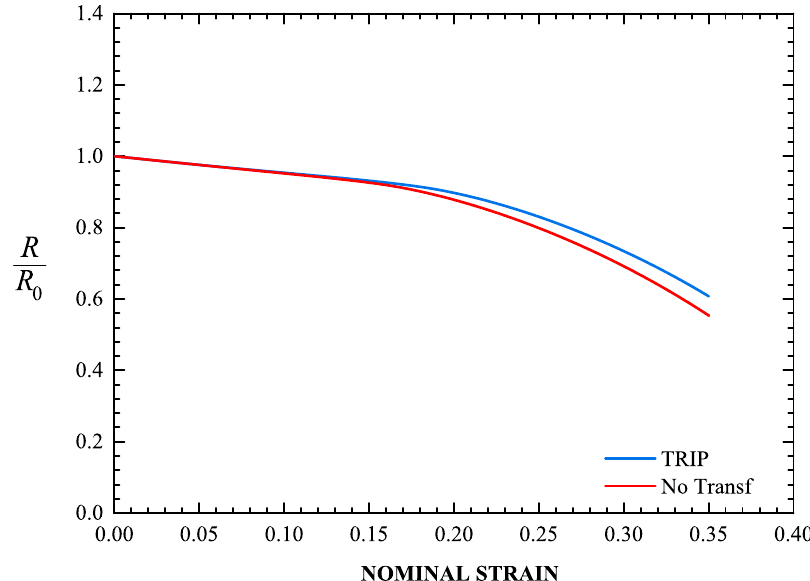
Figure 16. Evolution of the radius at the minimum cross section of the specimen for a transforming steel and a “non-transforming” steel.